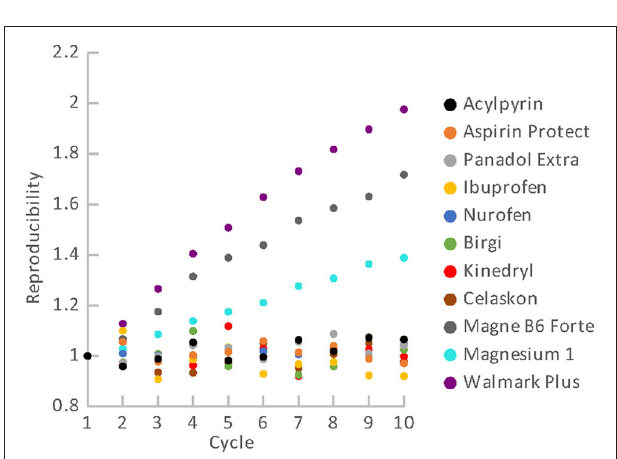
FIGURE 8 | Reproducibility of OSL signal for the pharmaceuticals and food